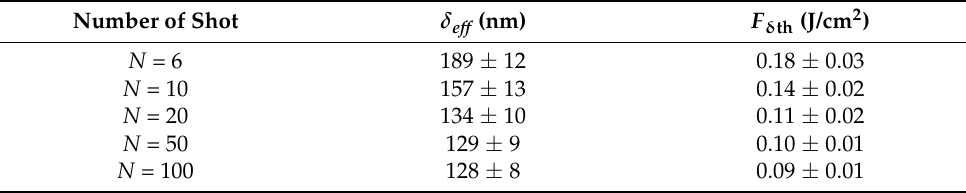
Table 2. Depth-regression-based ablation threshold ( F δ th ) and effective energy penetration depth ( δ eff ) for the 4211